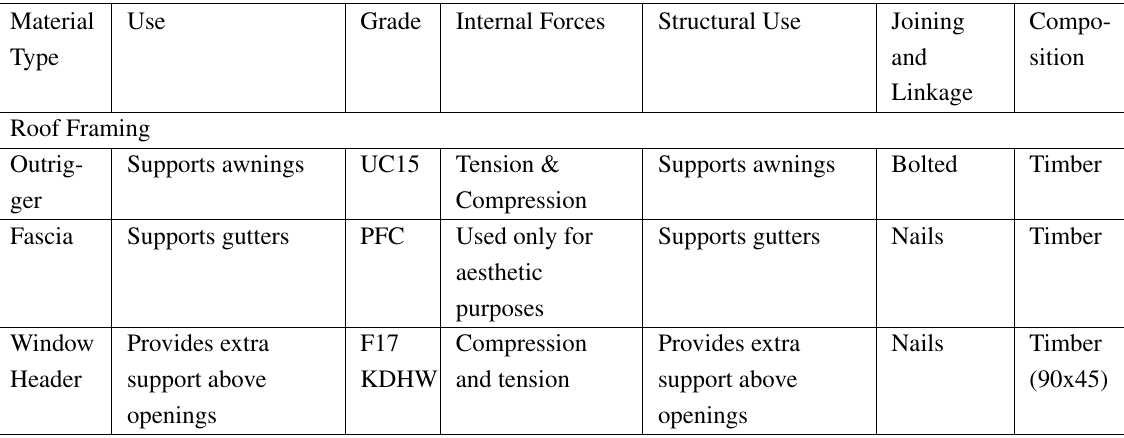
Table 3. Timberusage in